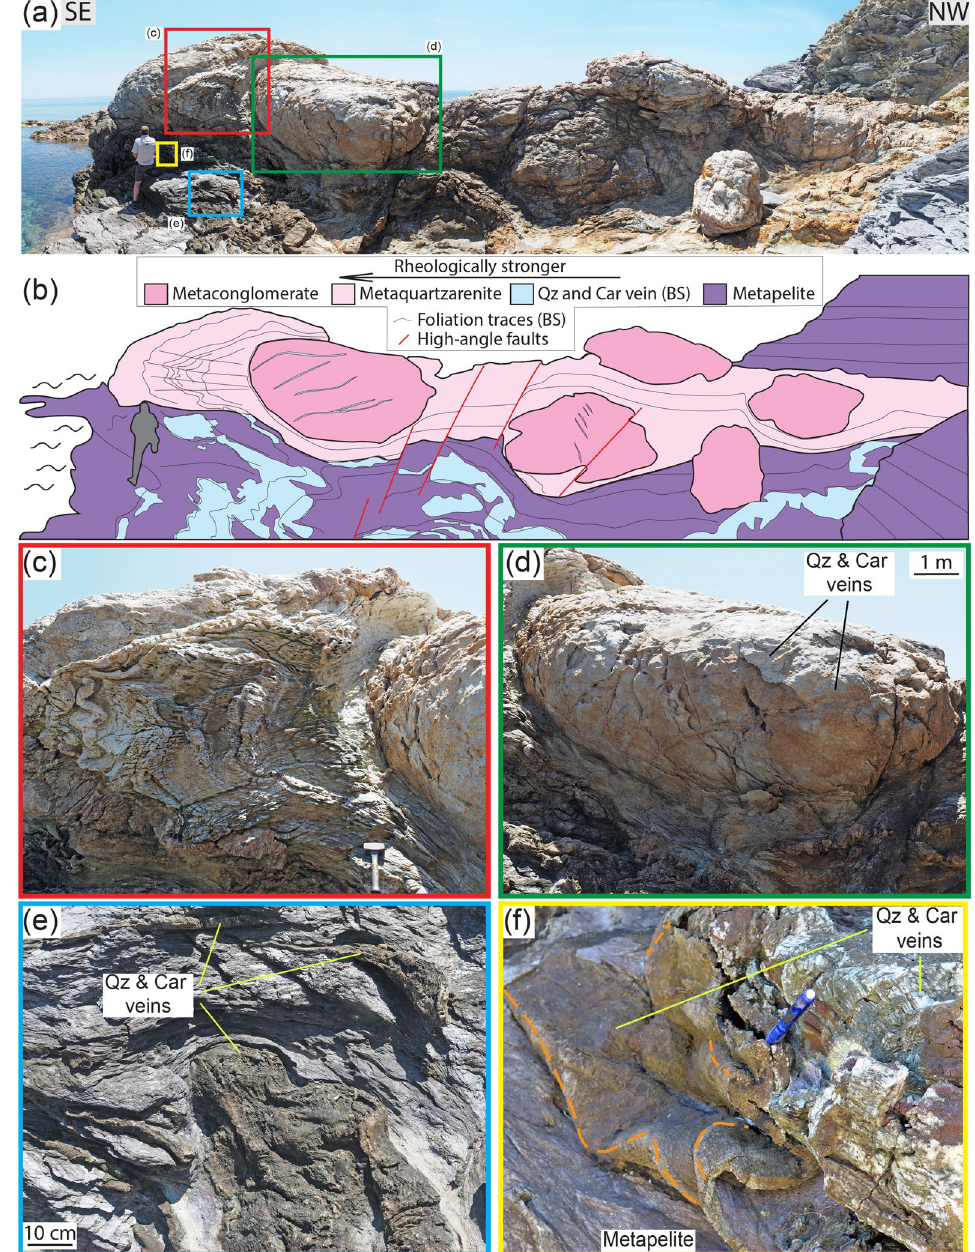
Figure 1. Outcrop ( a ) and interpretative sketch ( b ) of the Verrucano broken formation, with boudins of competent lithotypes (metaconglomerate, metaquartzarenite) embedded within weak metapelite. Quartz and carpholite veins occur in both metaconglomerate and metapelite. BS = blueschist facies conditions, see text for details. Giglio Island (Tuscany, Italy). ( c ) Detail of the contact between metaconglomerate boudin (right) and intensely and disharmonically folded metaquartzarenite. Folding style is likely due to the stark competence contrast causing local kinematic flow perturbations (see section “ Block in matrix” behaviour for further details). ( d ) Detail of metaconglomerate boudin with quartz and carpholite veins arranged in an en-echelon array. ( e ) Metapelite with folded dilational hydroshear veins composed of quartz and carpholite fibres. ( f ) Detail of non- cylindrical folding of dilational hydroshear vein. Dashed orange lines indicate curvilinear fold hinges; the pen is oriented subparallel to the stretching lineation. Mineral abbreviation in figures from 43 . Figure ( b ) created with Adobe Illustrator CS6 (https:// www. adobe. com/ produ cts/ illus trator.